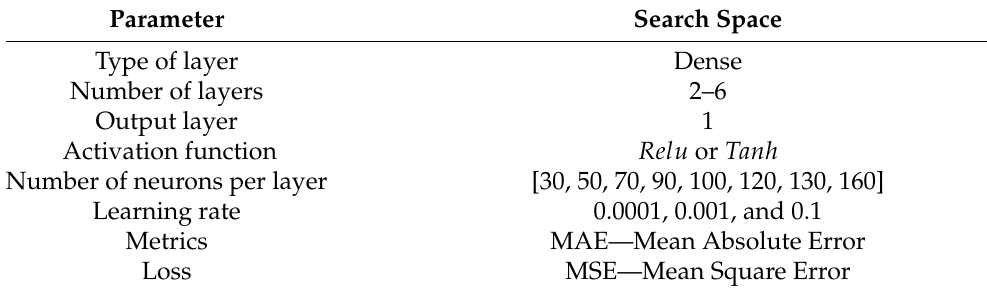
Table 6. Hyperband hyperspace search.